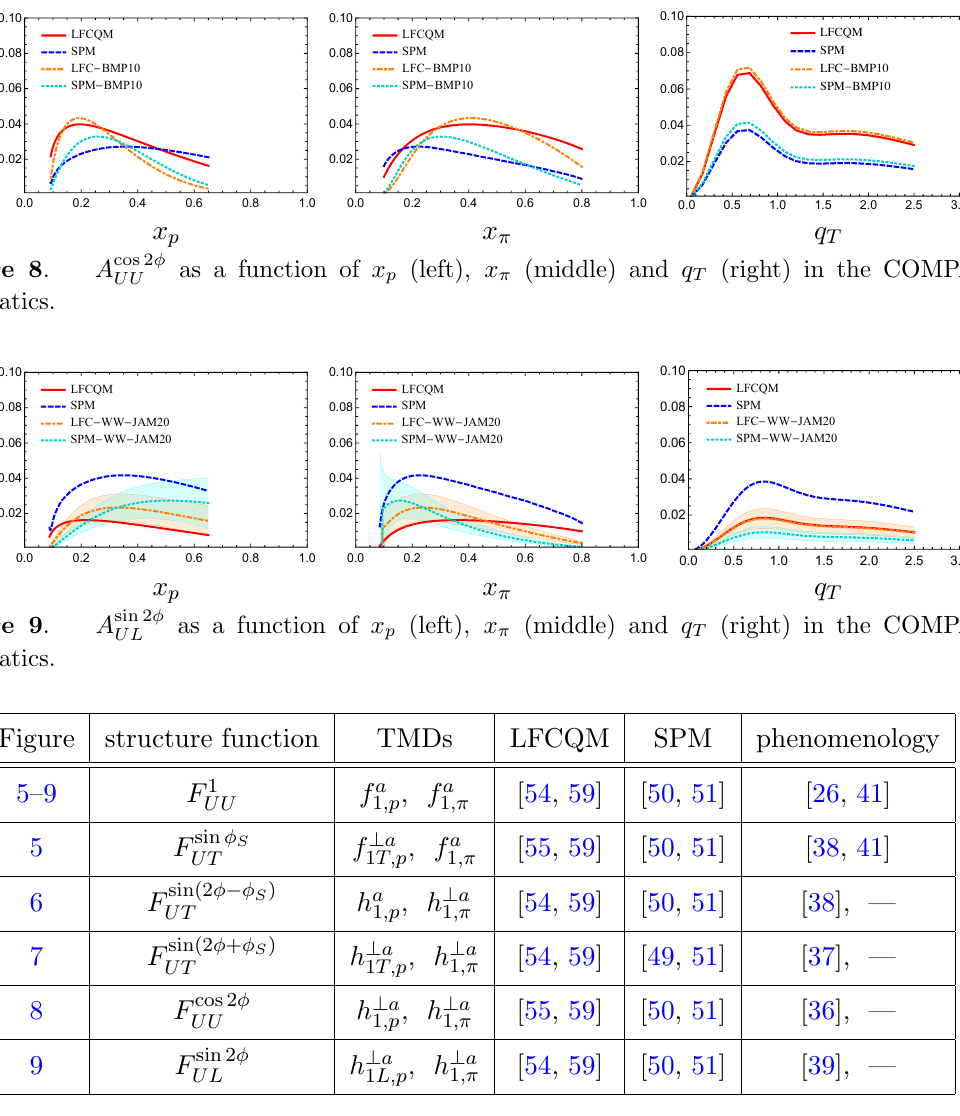
Table 1 . Overview on non-perturbative input used to produce the results in (cid:12)gures 5{9 which was taken from the LFCQM, the SPM, and phenomenological (cid:12)ts (or WW-type approximation in the case of h ? a ). Notice that no phenomenological information is currently available on h ? a 1 L;p section